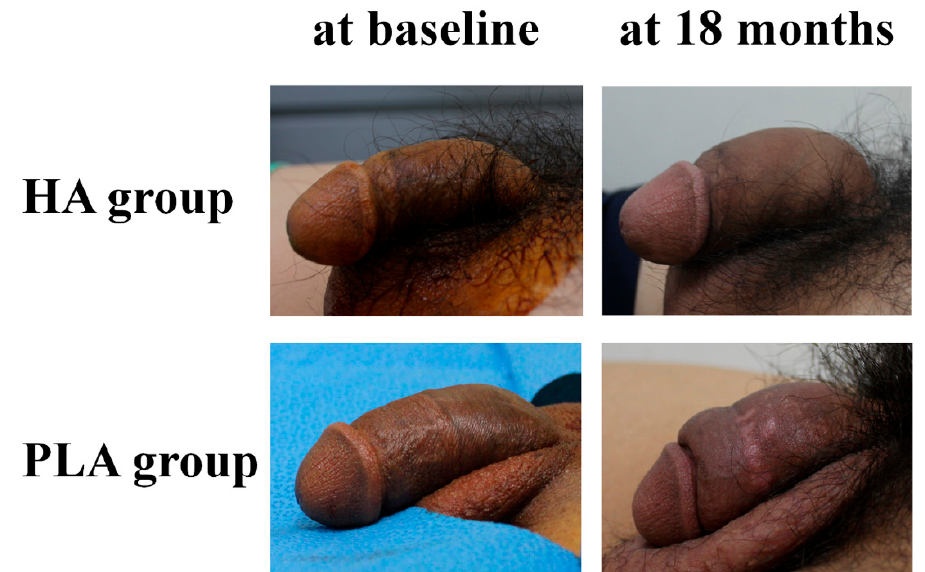
Figure 2. Representative photos of penis before and after hyaluronic acid and polylactic acid filler injections (identification number of patient: R01-23 in the HA group, and R01-03 in the PLA group). HA, hyaluronic acid; PLA, polylactic acid.